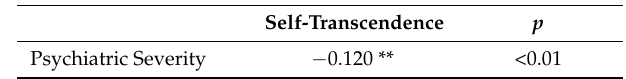
Table 7. Statistically significant correlations between Self-Transcendence (TCI-R) and severity factors of the EIDA, OCDS and EuropAsi scales. (** p < 0.001).